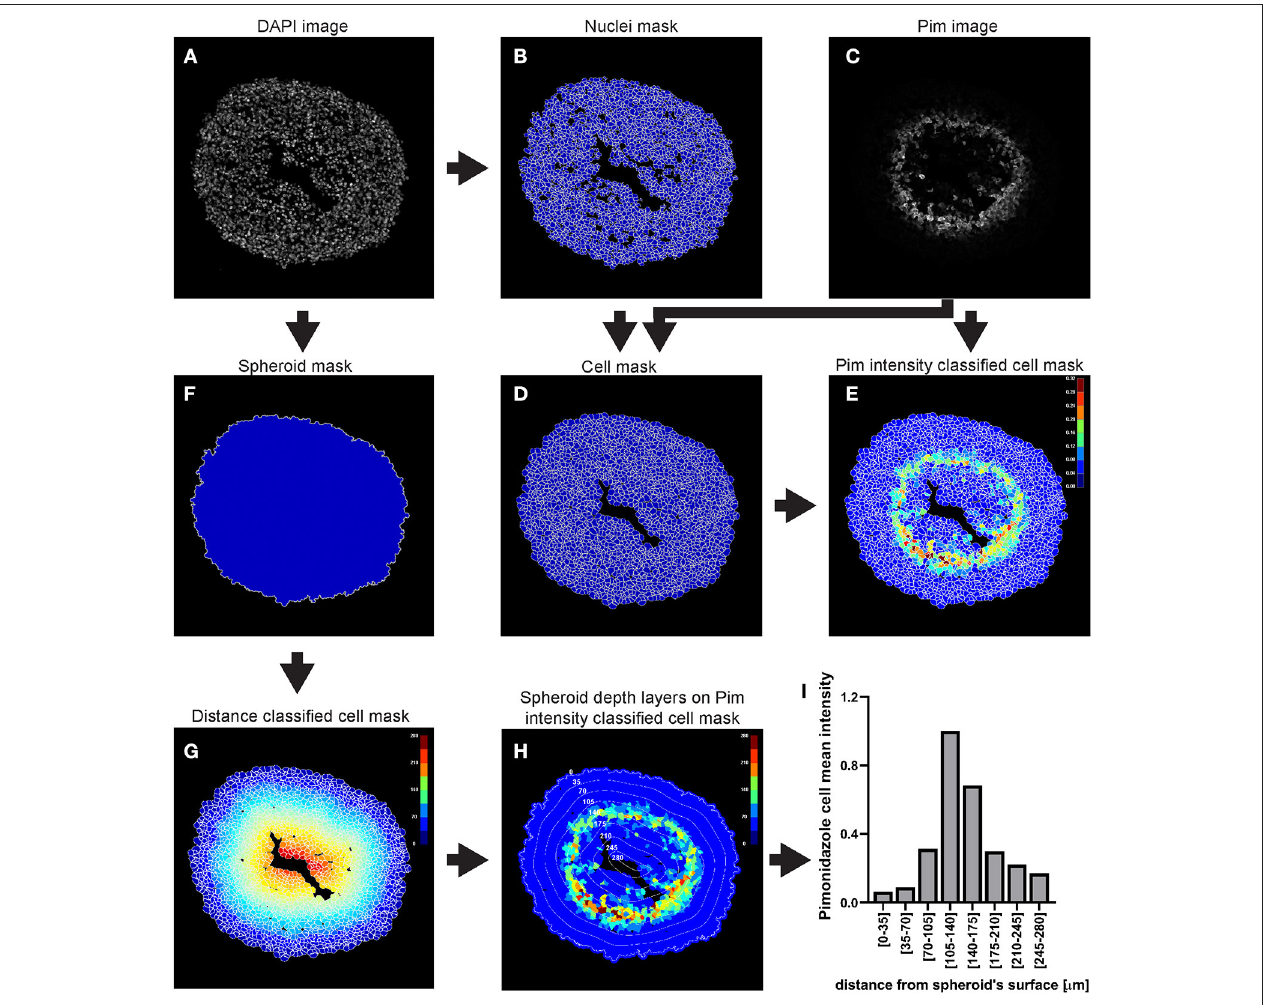
FIGURE 3 | Main steps of CellProfiler pimonidazole image analysis. The DAPI image (A) is used to identify the nuclei a as primary objects (B) which in turn are exploited as “seed” regions, together with the pimonidazole image (C) , to outline their cytoplasmic area and define cells (nucleus + cytoplasm) (D) . Pimonidazole fluorescent signal is then measured for each cell (E) . The DAPI image (A) is also used to determine the spheroid outline (F) which is then exploited to measure the distance of each cell from the spheroid surface (G) . The data obtained from the CellProfiler analysis can be used to generate a profile of the pimonidazole cells mean intensity at different depths in the spheroid (H,I) . The colour-coded scales indicate signal intensity in arbitrary units (E,H) and distance in µ m (G) . In (H) the numbers labelling the depth curves indicate the distance from the spheroid’s surface in µ